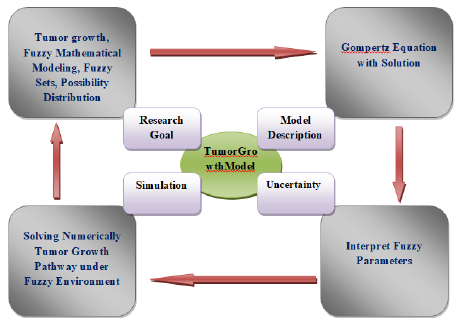
Figure 1. The framework of the tu- mor growth